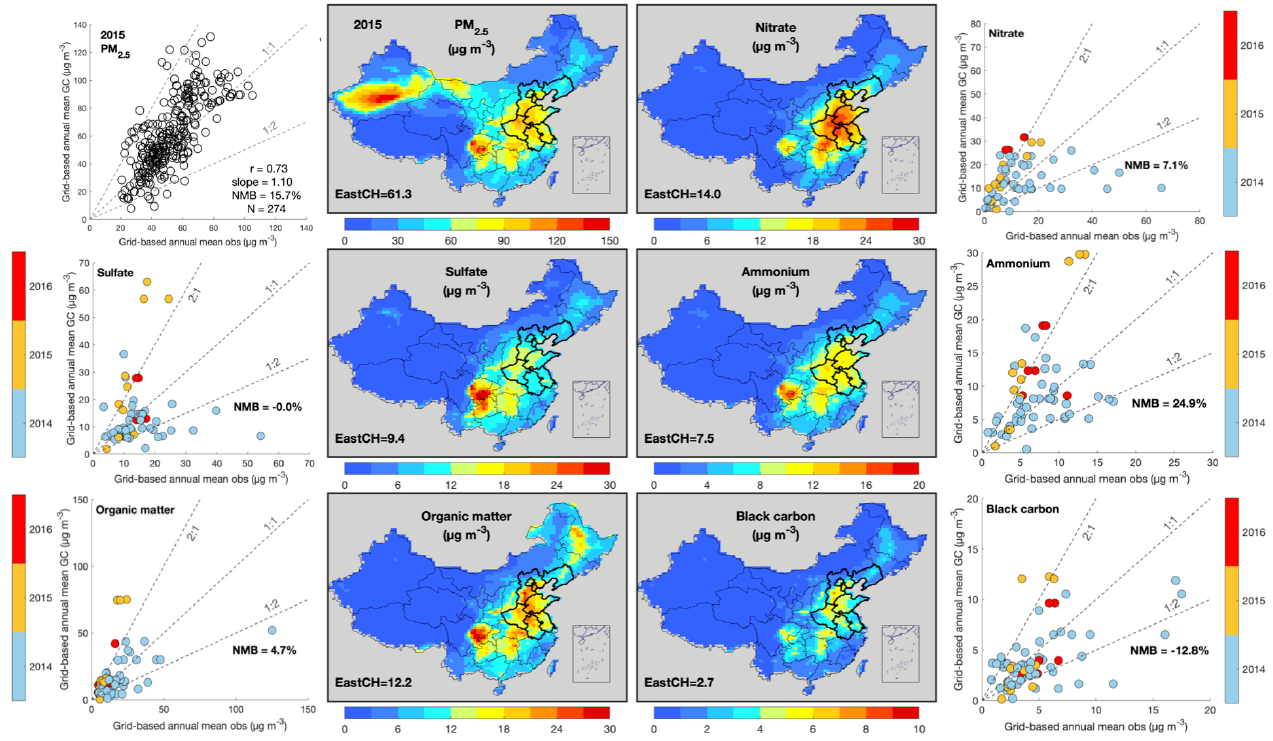
Figure 1. Total and compositional PM 2 . 5 concentrations in China. Spatial distributions of PM 2 . 5 and composition concentrations are annual- mean concentrations simulated by the GEOS-Chem model for January, April, July, and October 2015 with a resolution of 0.5 ◦ × 0.625 ◦ . We regard the mean of the 4 months as the annual mean. Thick black lines outline eastern China, as discussed in this work. Text in the bottom left corner of each map refers to mean concentrations (µgm − 3 ) over eastern China. The scatterplot of PM 2 . 5 compares the simulated annual-mean concentrations with collocated and coincident observations for 2015 from the CNEMC network. Scatterplots of composition compare both annual and monthly concentrations of the observed and the coincident simulated concentrations according to the availability of observations from the literature for